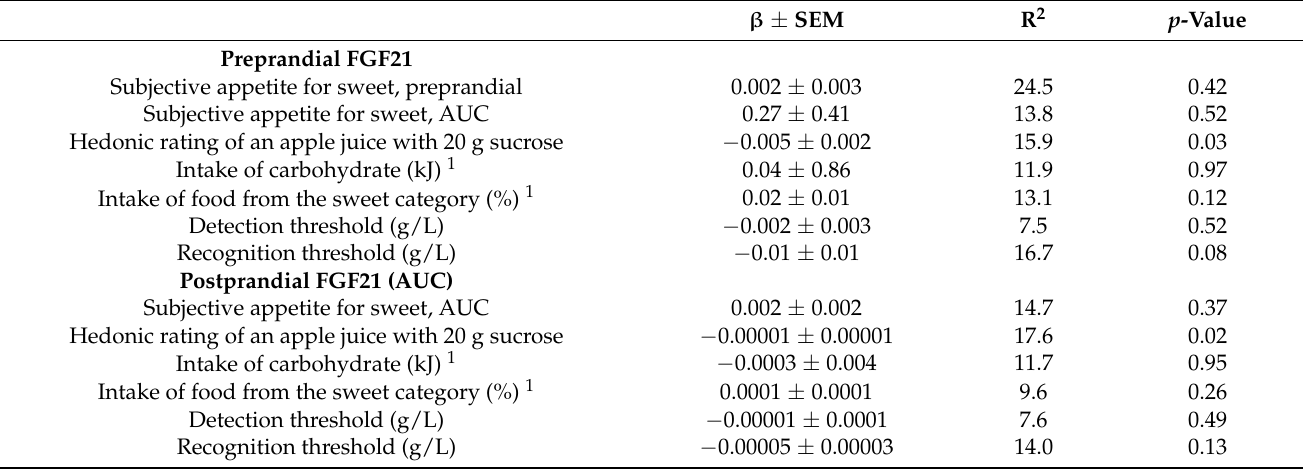
Table 1. Cross-sectional associations 1–2 weeks before bariatric surgery between FGF21 and measures of sweet preference and intake and sweet taste sensitivity.